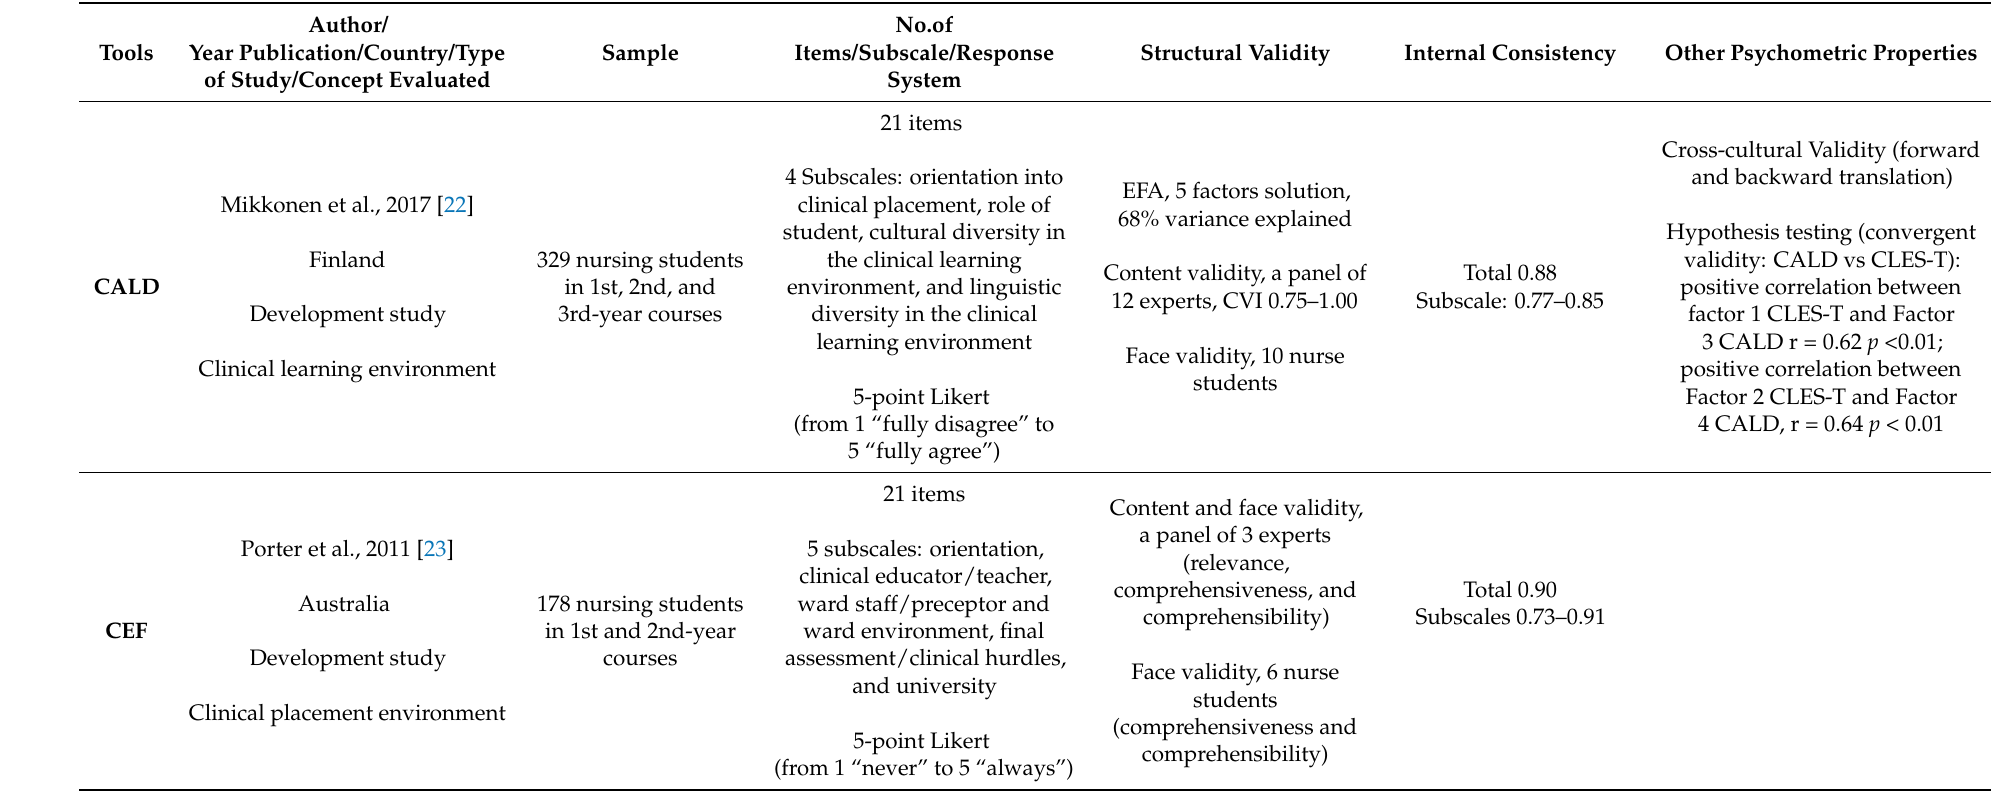
Table 1. Studies included in the review and psychometric properties of the instruments